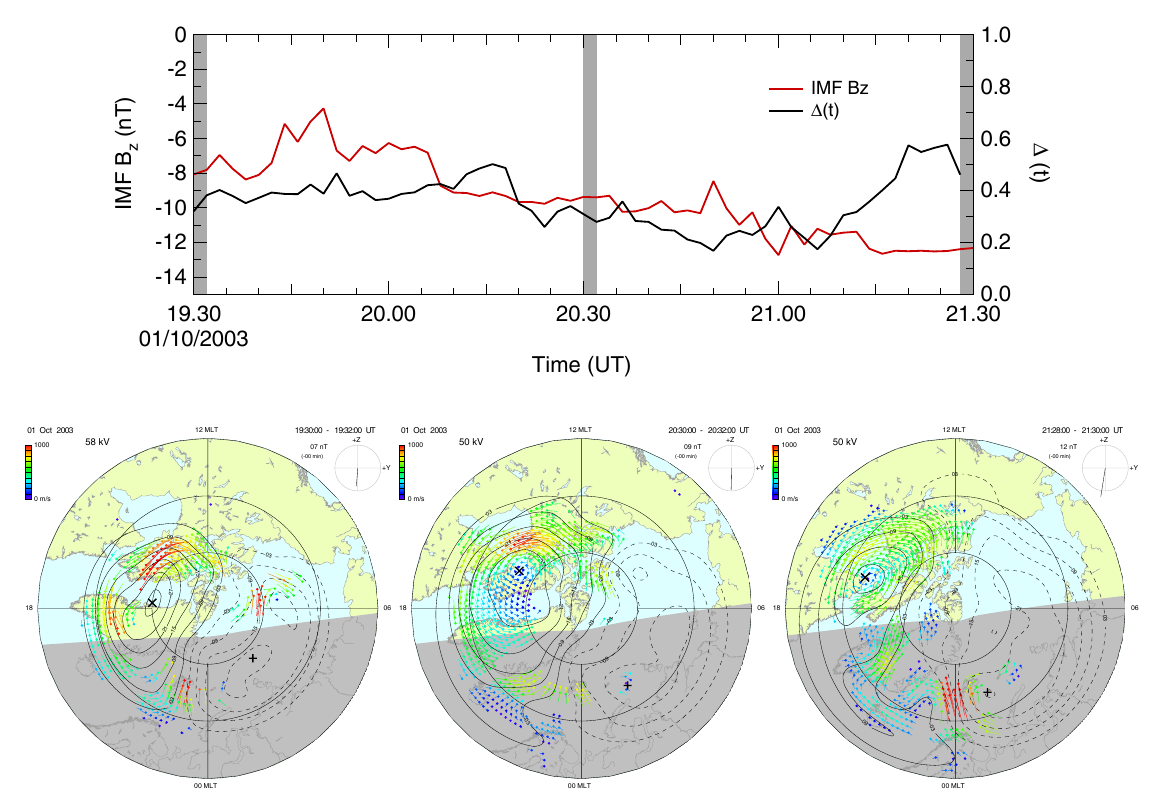
Fig. 1. Upper panel: IMF B z (red, axis on the left) as obtained by OMNI, and normalised disorder degree Δ( t ) (black, axis on the right), for the period 01/10/2003, 19:30 – 21:30 UT. Lower panel: three samples of SuperDARN convection maps for the same period; the 2-minute scan intervals represented in the maps are shaded in the upper panel plot.